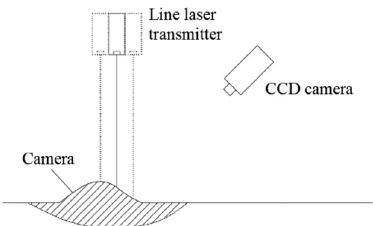
Figure 10. Scanning at different positions of the line laser transmitter.